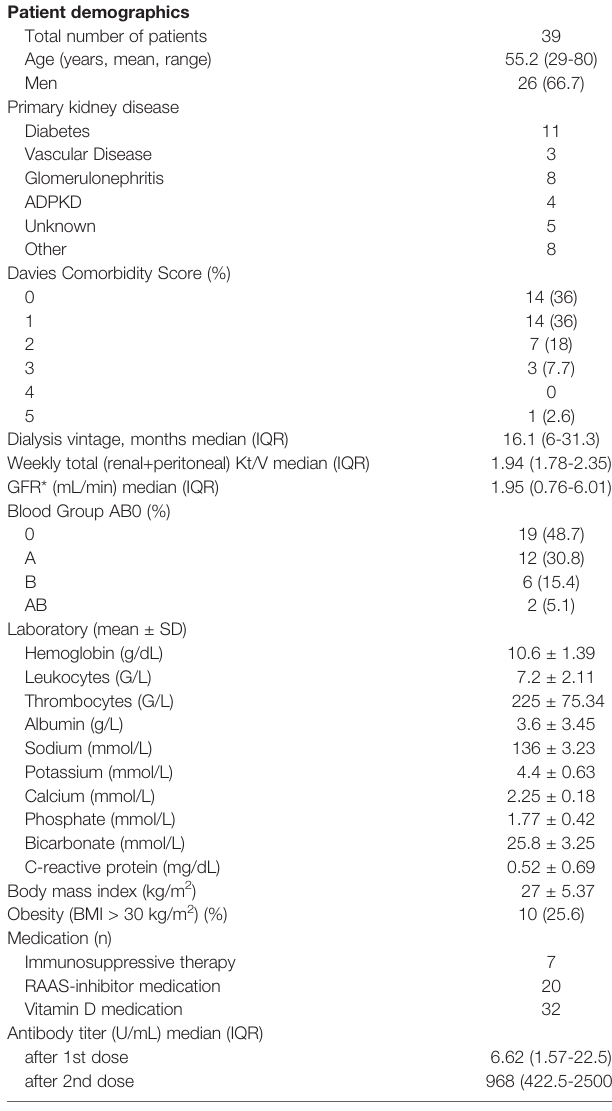
TABLE 1 | Characteristics of peritoneal dialysis patients vaccinated with Moderna ® mRNA-1273 vaccine. Patient demographics Total number of